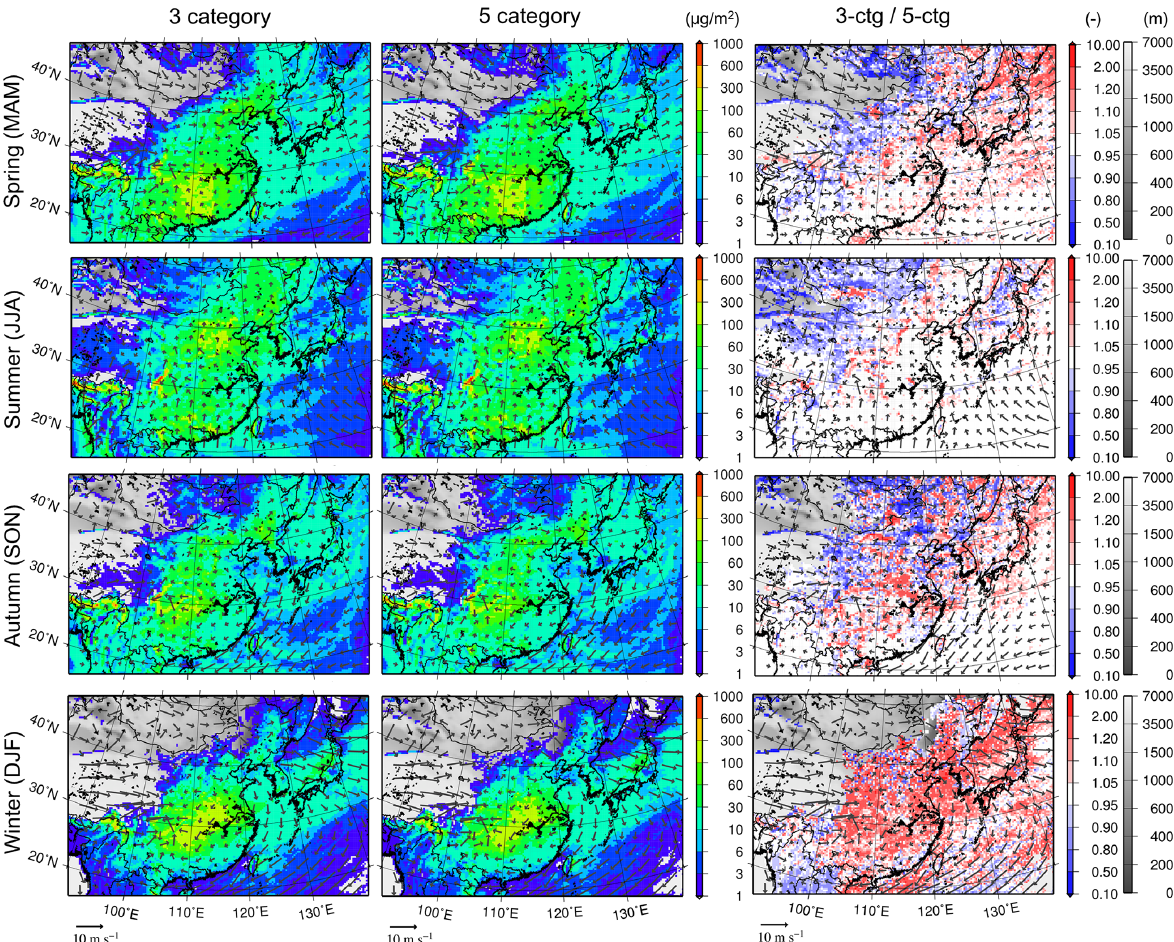
Figure 10. Same as Fig. 9 but for the total (dry + wet) deposition of